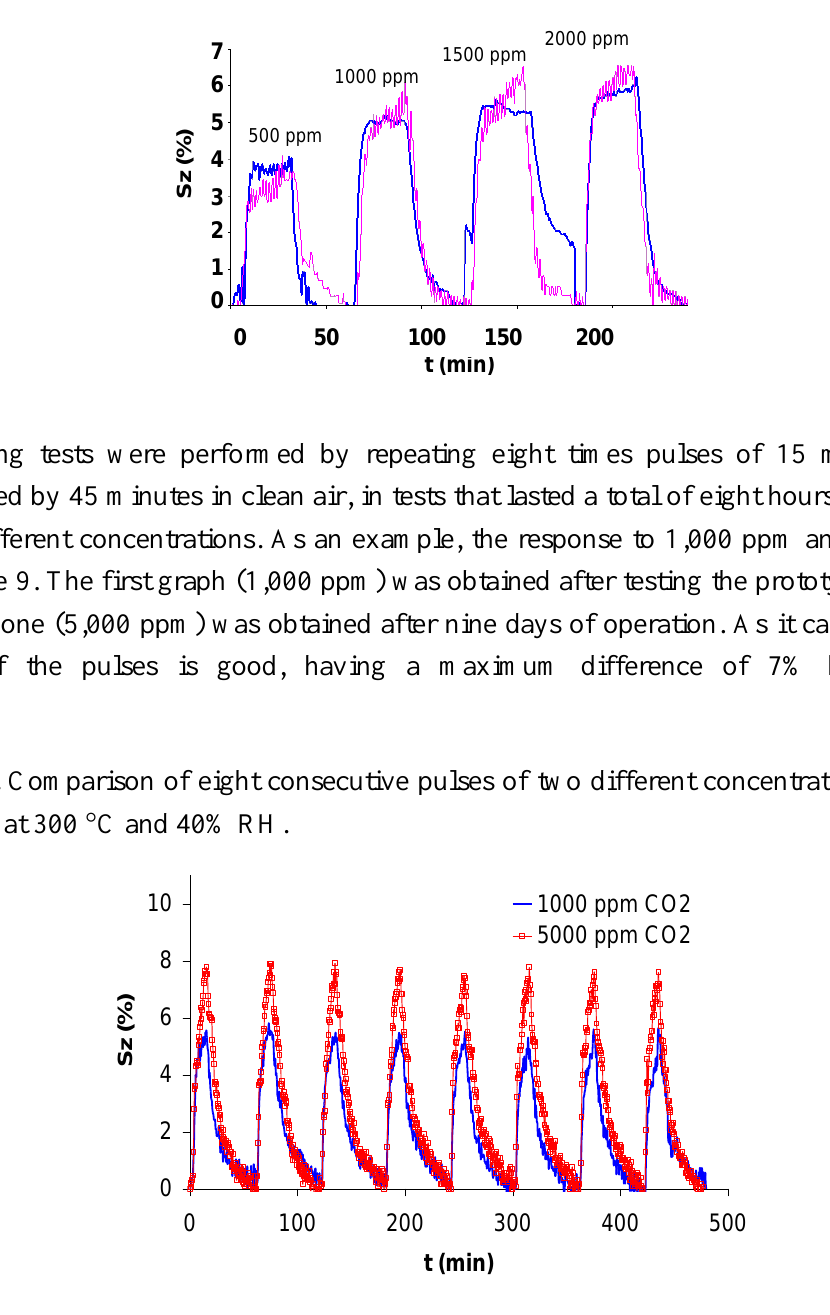
Figure 8. Dynamic response to carbon dioxide of two different samples within a range of 500 to 2,000 ppm, measured at 300  C and 40% RH.